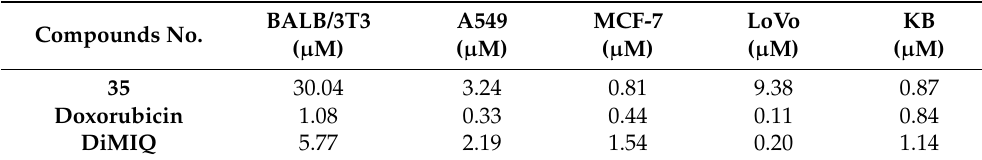
Figure 39. Structure of quinoline ‐ guanidine based hybrid 35.